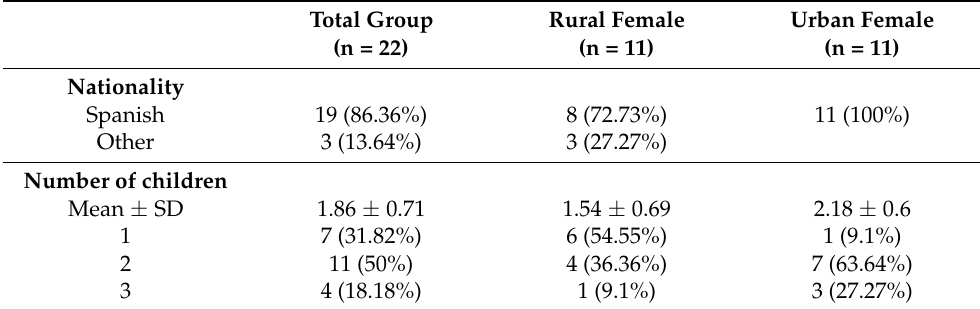
Table 2. Socio-demographic characteristics of the sample